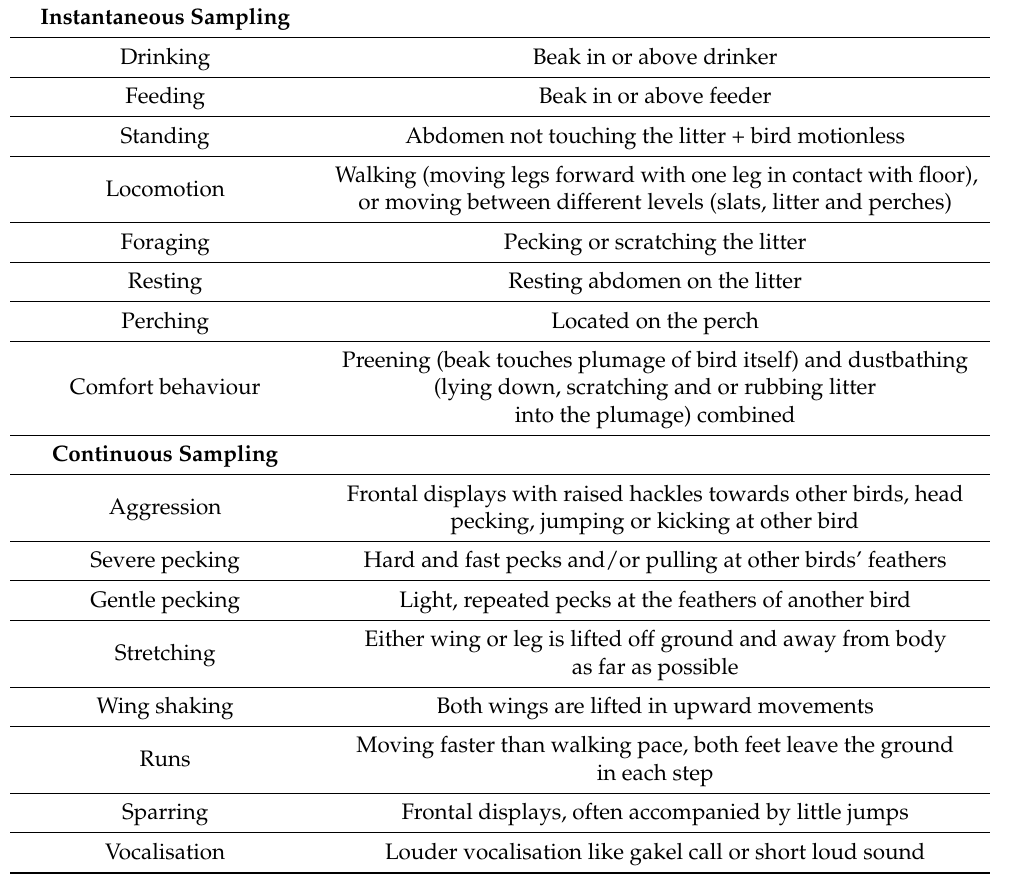
Table 1. Ethogram of behaviours observed in the home pens and their description, divided into behaviours observed with instantaneous sampling and with continuous